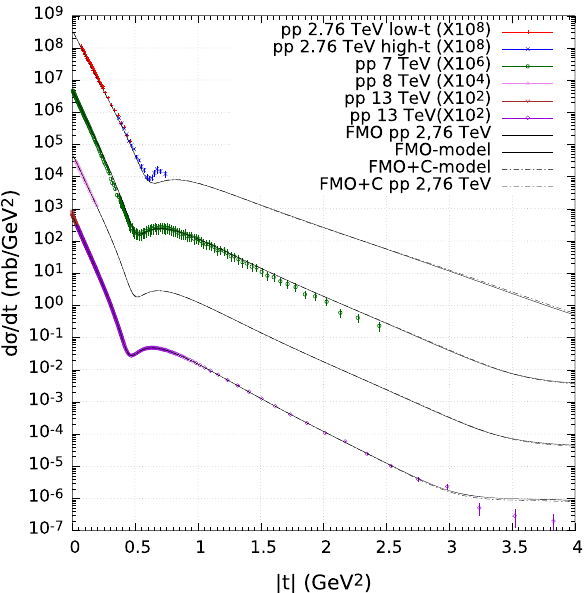
Fig. 6 Differential pp cross sections at the lowest | t | and at LHC ener- gies